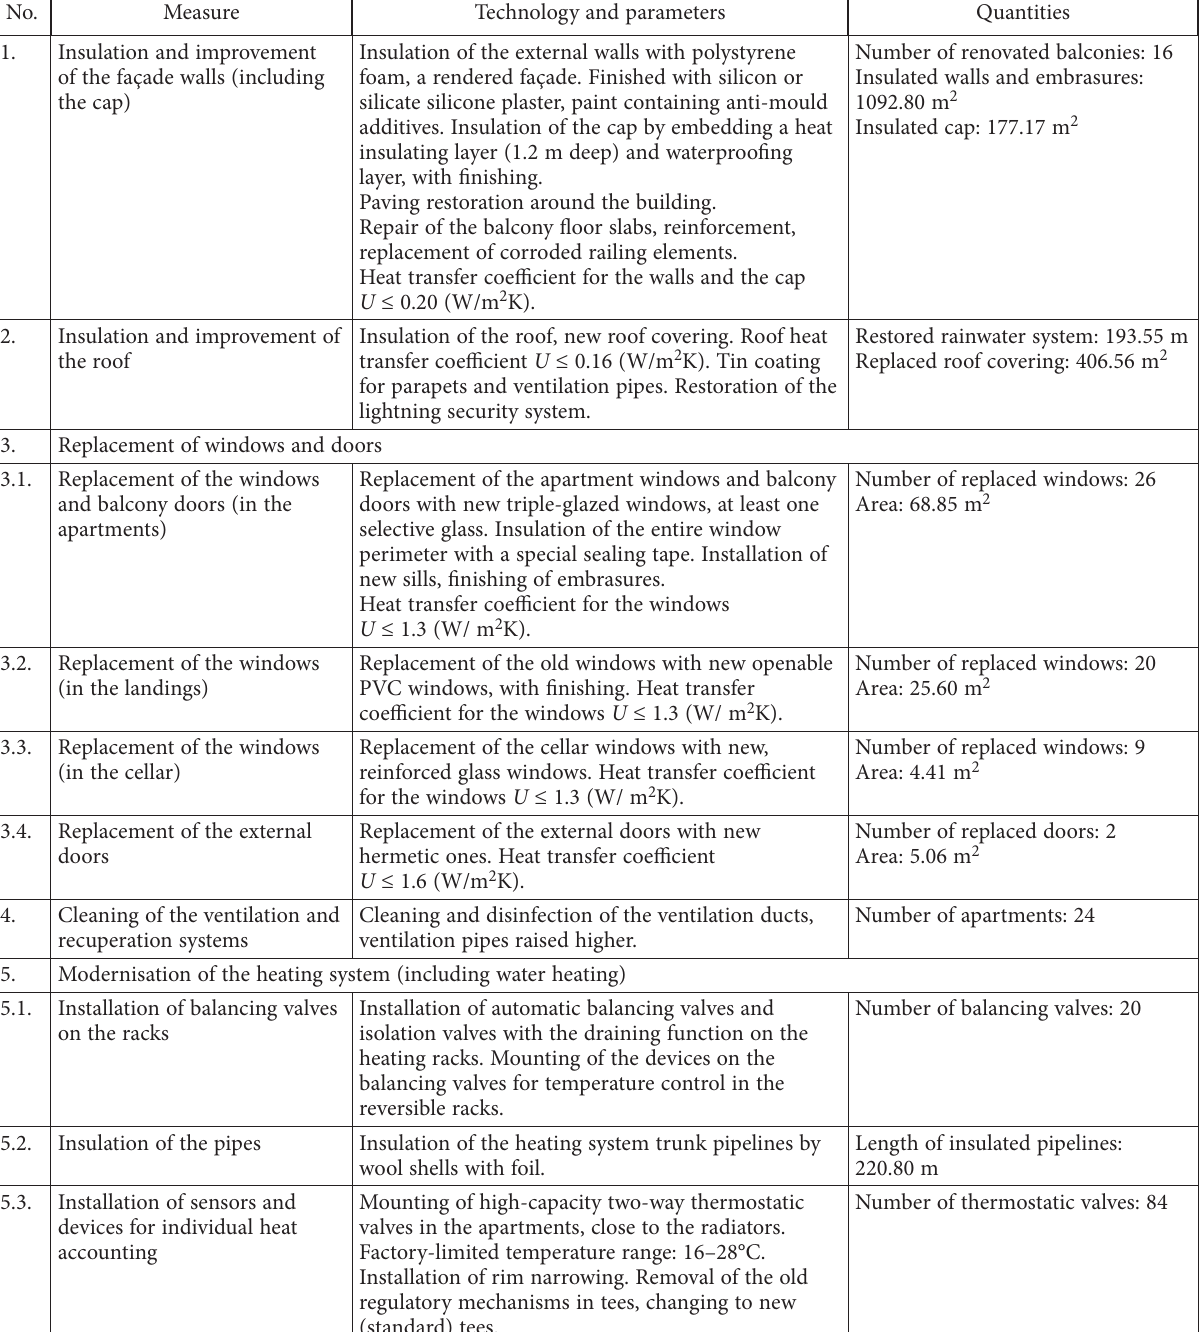
Table 7. Proposed refurbishment measures for Alternative